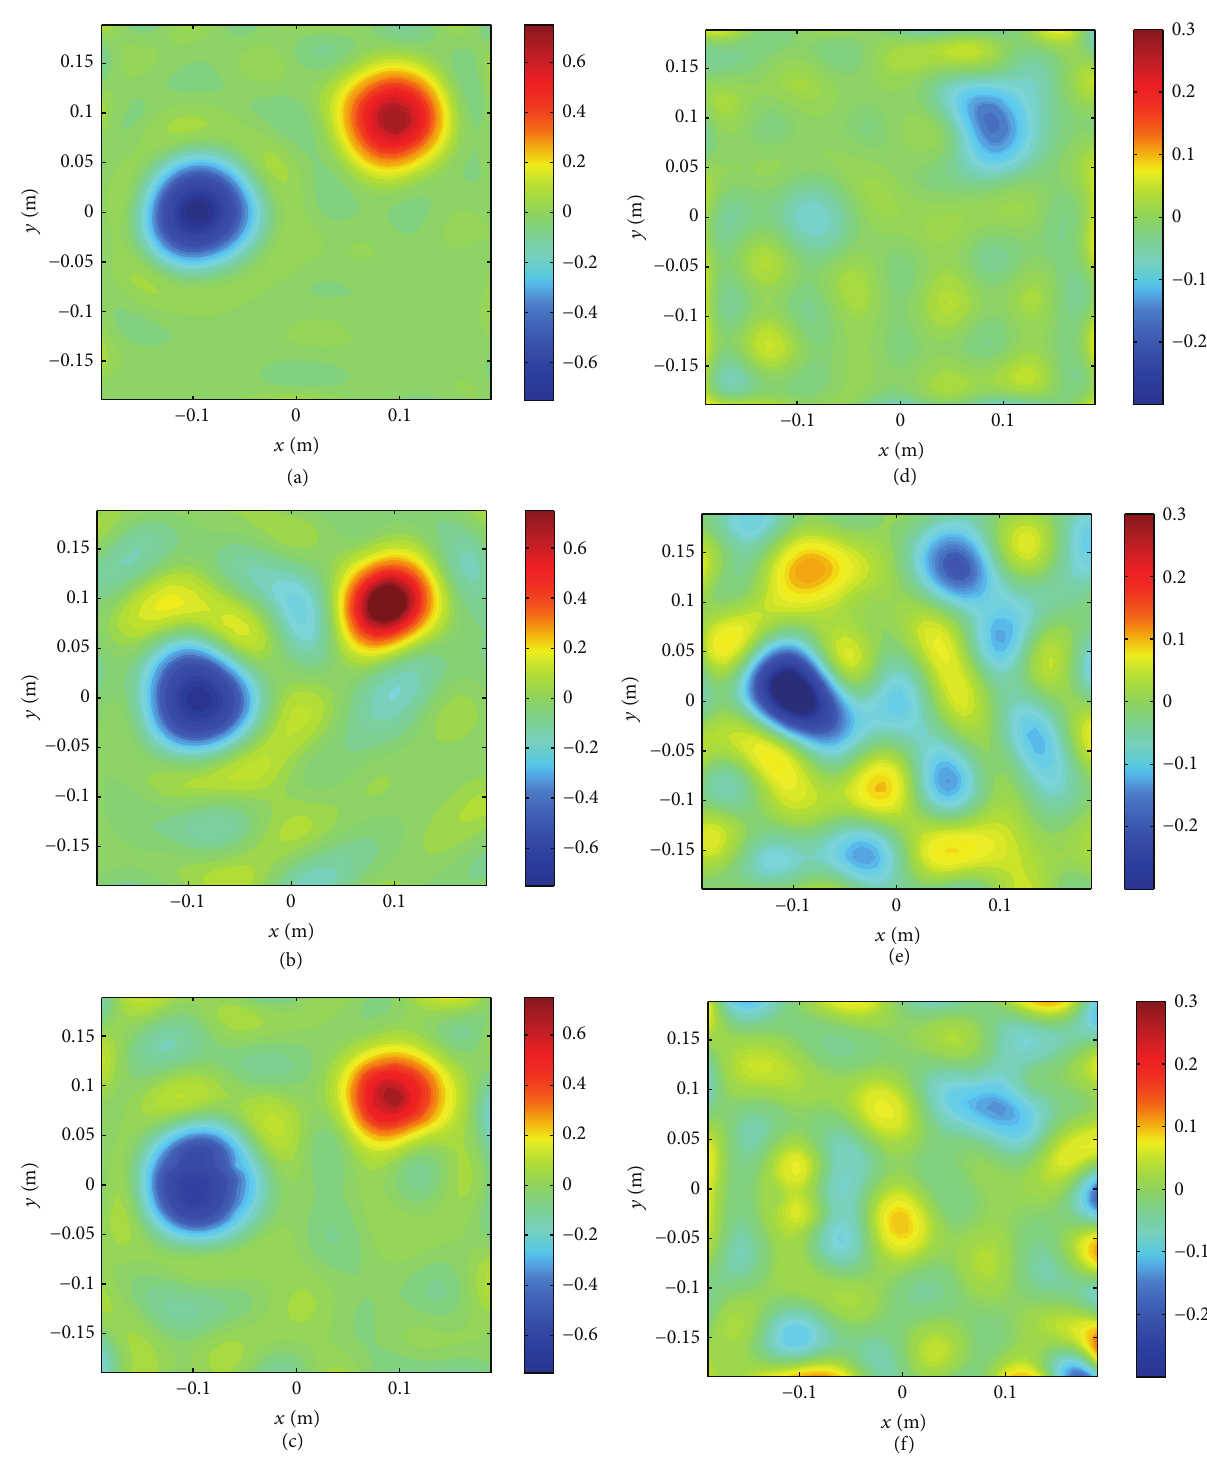
Figure 15: Example 1: reconstructions in the circular cavity. ((a), (d)) Real and imaginary parts of retrieved contrast function assuming the “exact” scattering operator; ((b), (e)) real and imaginary parts of retrieved contrast function by measn of the DBIM; ((c), (f)) real and imaginary parts of retrieved contrast function via